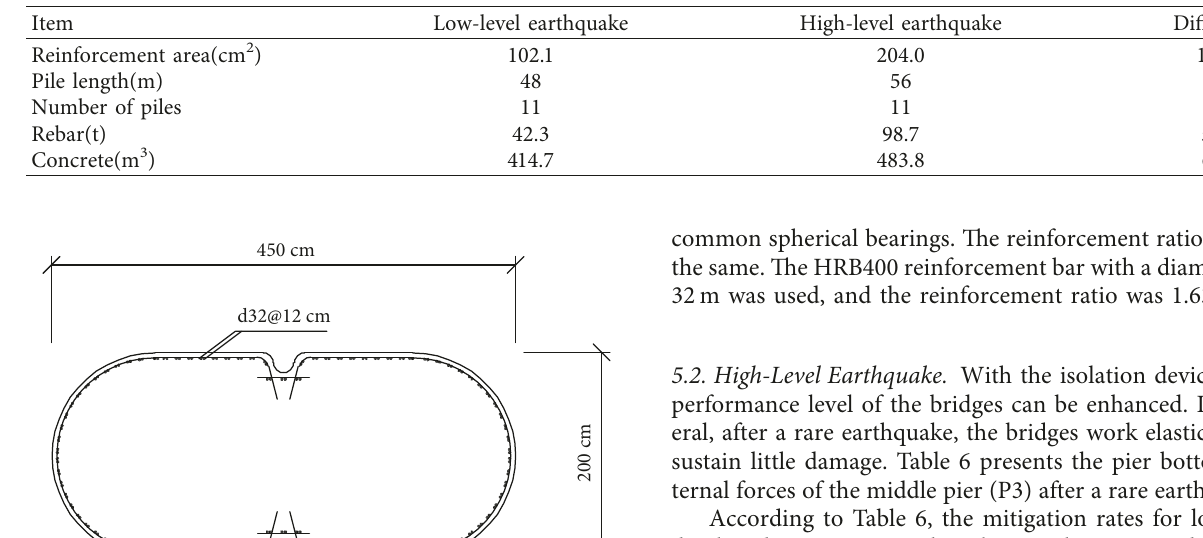
Table 5: Parameters for low-level and high-level